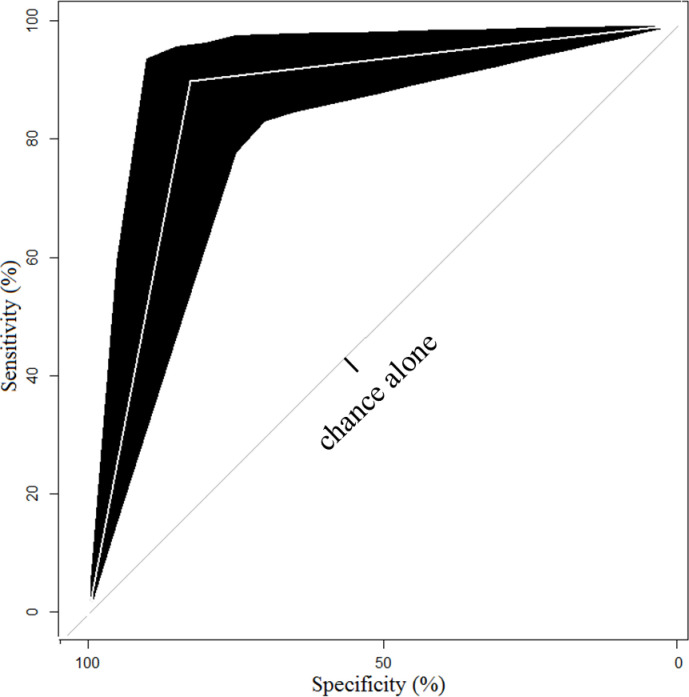
Receiver operating characteristic curve of the blastocyst optimization model.The accuracy of the decision tree was calculated at 86.5% with an error rate of 13.5%. The area under the ROC curve (Robin et al. 2011), which is a plot of the true positive rate (sensitivity) against the false positive rate (specificity), is approximately 0.87 with confidence intervals of 0.7996–0.9312. This indicates that any final node on the model will yield 29% greater success than chance alone at the lowest predictive accuracy and 43% greater success than chance alone at its highest predictive accuracy. This is added validation of the predictive model in the current study.